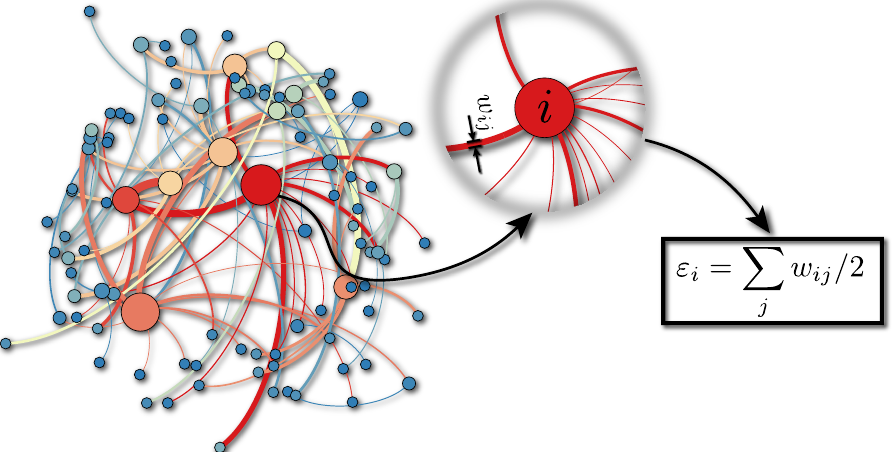
Figure 24. Sample of a network with 100 sites for the following model parameters ( d , α A , α G , η , w 0 ) = ( 2,1,5, 1,1 ) , where α A and α G respectively characterize the attachment and geographical ranges; η and w 0 are parameters of the distribution of widths. As illustrated for this choice of parameters, hubs (highly connected nodes) naturally emerge in the network. Each link has a specific width w ij and the total energy ε i associated with the site i will be given by half of the sum over all link widths connected to the site i (see zoom of site i ). From [136].